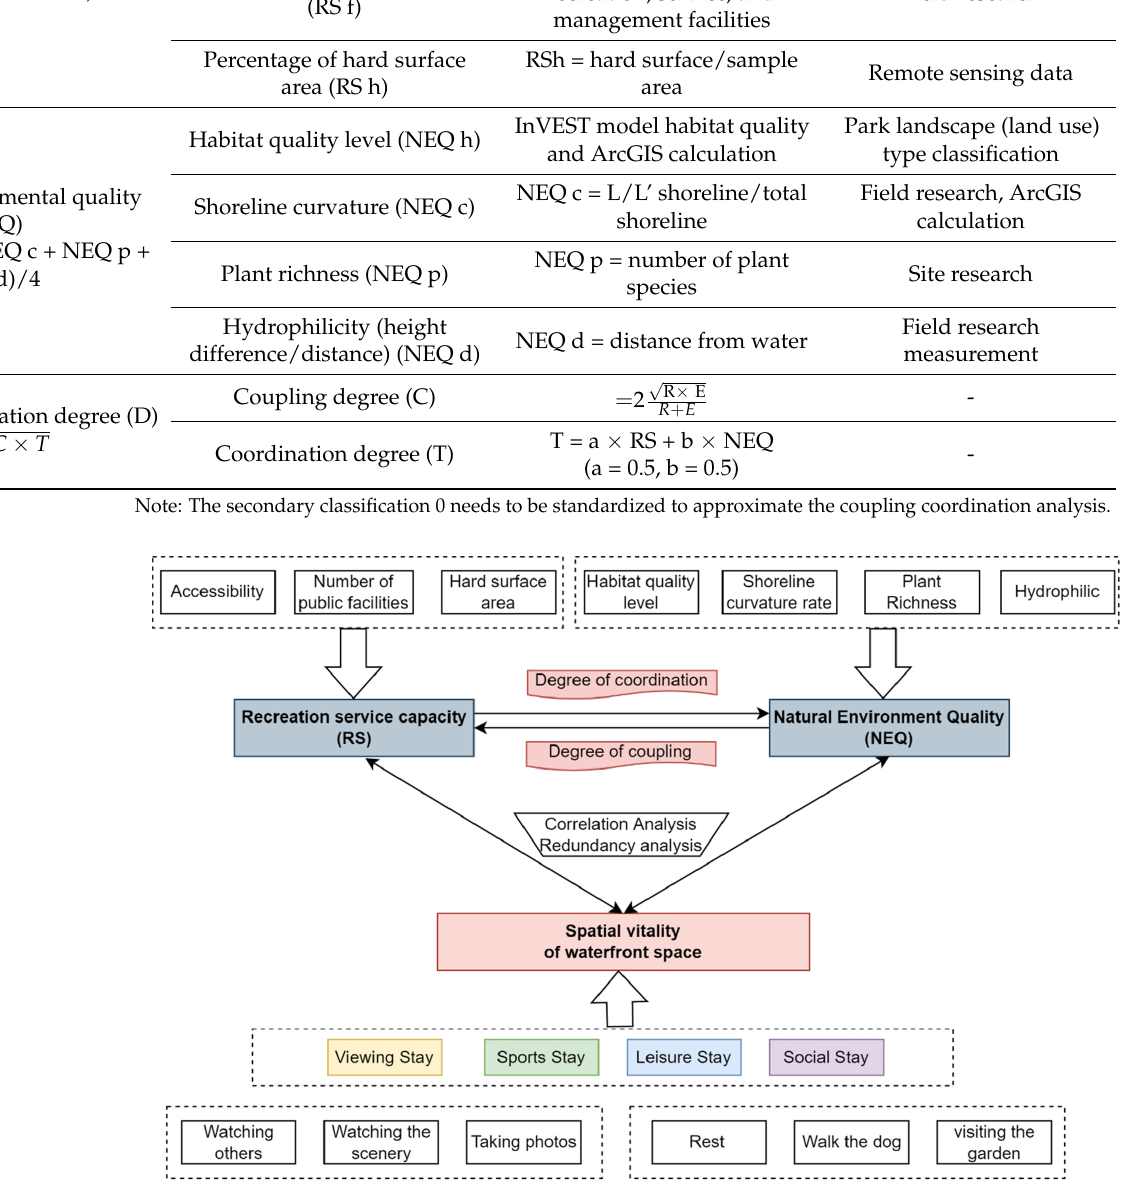
Table 1. Calculation and data acquisition methods for the spatial characteristic variables of green space.